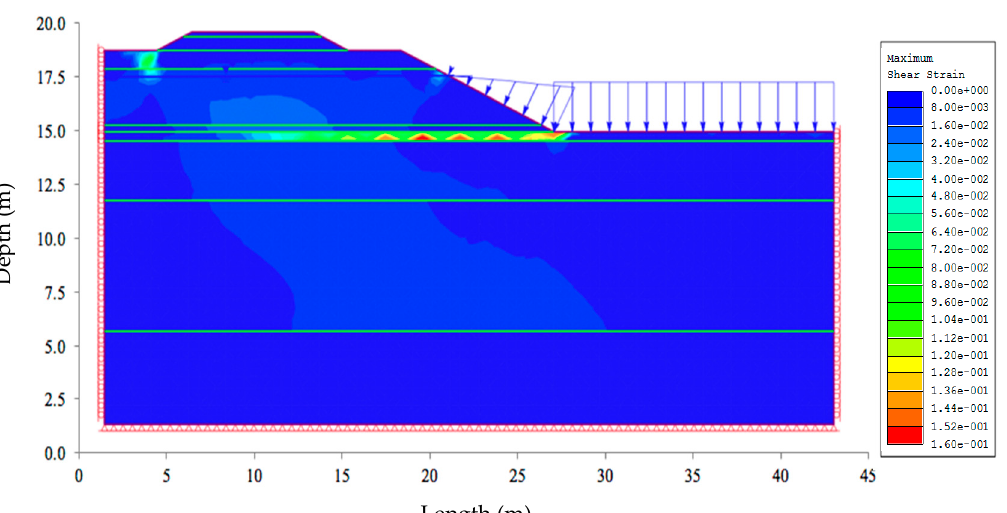
Figure 12. Colored contour shading of maximum shear strain (base case).